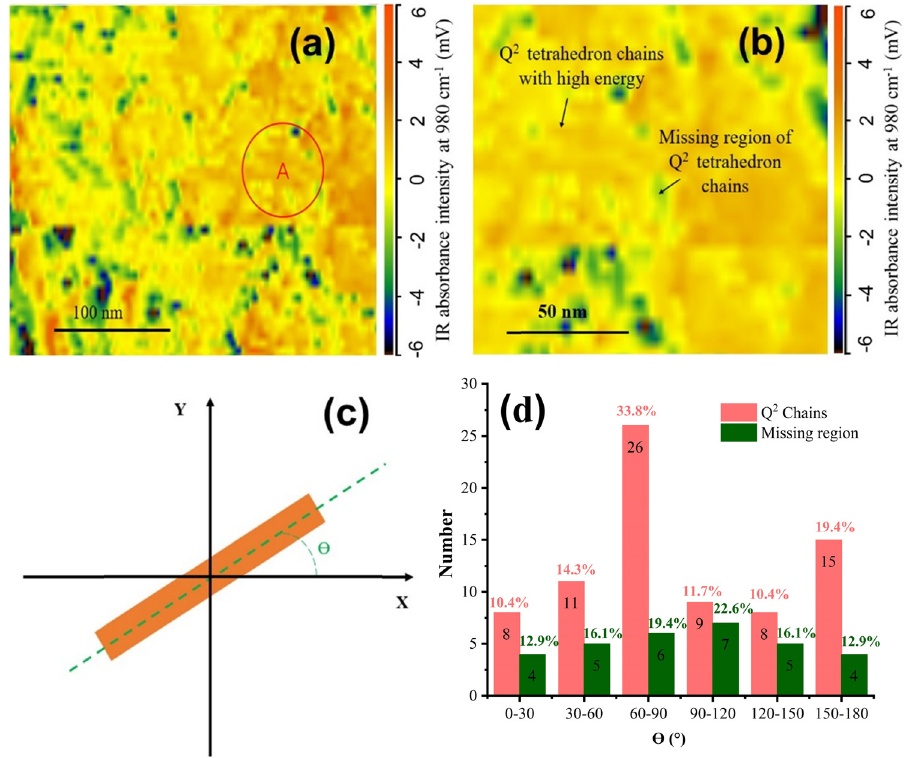
Figure 8: AFM - IR mapping results for a separate region near that shown in Figure 5 ( a ) : ( a ) entire region; ( b ) magni fi ed region associated with the region marked in Figure 5 ( a ) ( c ) Illustration of the orientation of connective and the missing region of Q 2 chains based on an angle Ɵ in the range of 0 – 180°; ( d ) Distributions of connective and the missing region of Q 2 chain orientations in Figure 6 ( a )